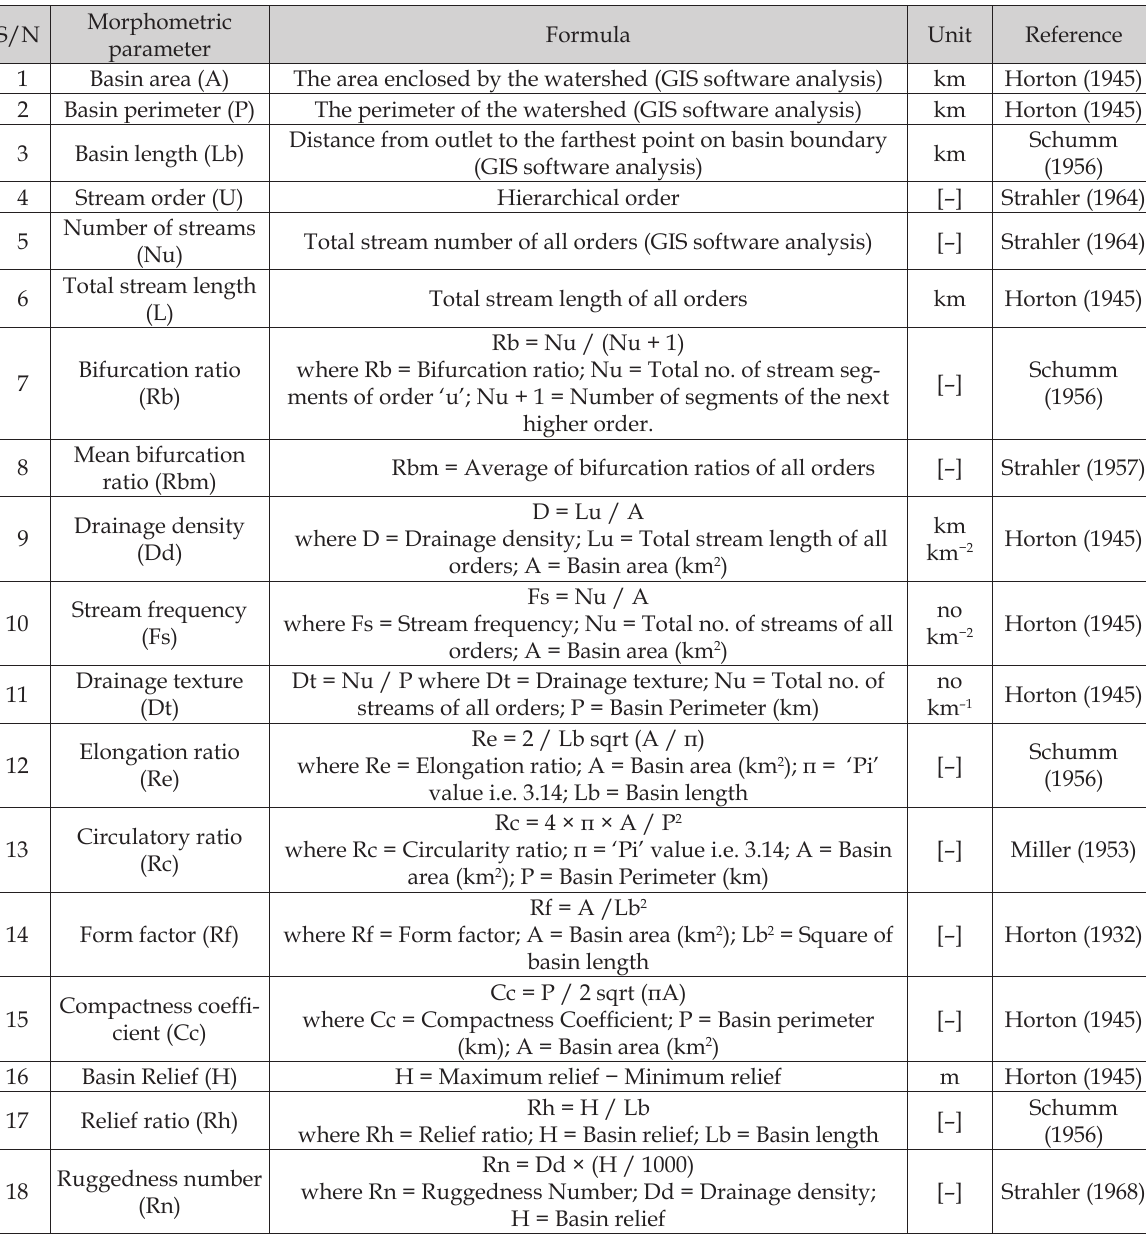
Table 1. Formulas adapted for the computation of morphometric